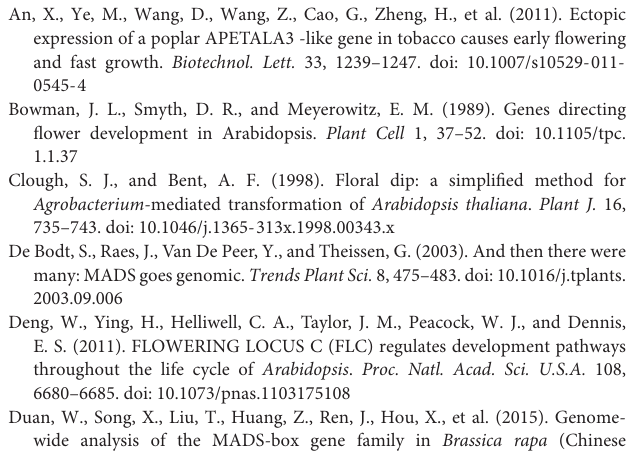
FIGURE S3 | Expression analysis of predicted downstream genes of BcAP3 in BcMAF1 -overexpressing Arabidopsis (A) and BcMAF1 -silencing Pak-choi (B) . FIGURE S4 | Changes in BcMAF1 transcript in response to LD and SD were monitored in Pak-choi by qPCR. Data shown are means ± SEM of three independent experiments. TABLE S1 | Primers used in the paper. TABLE S2 | Sequences of oligonucleotides used for VIGS. TABLE S3 | Information of the promoters of BcMAF2 and BcAP3 . TABLE S4 | Days from sowing to the time of bolting in the silenced Pak-choi